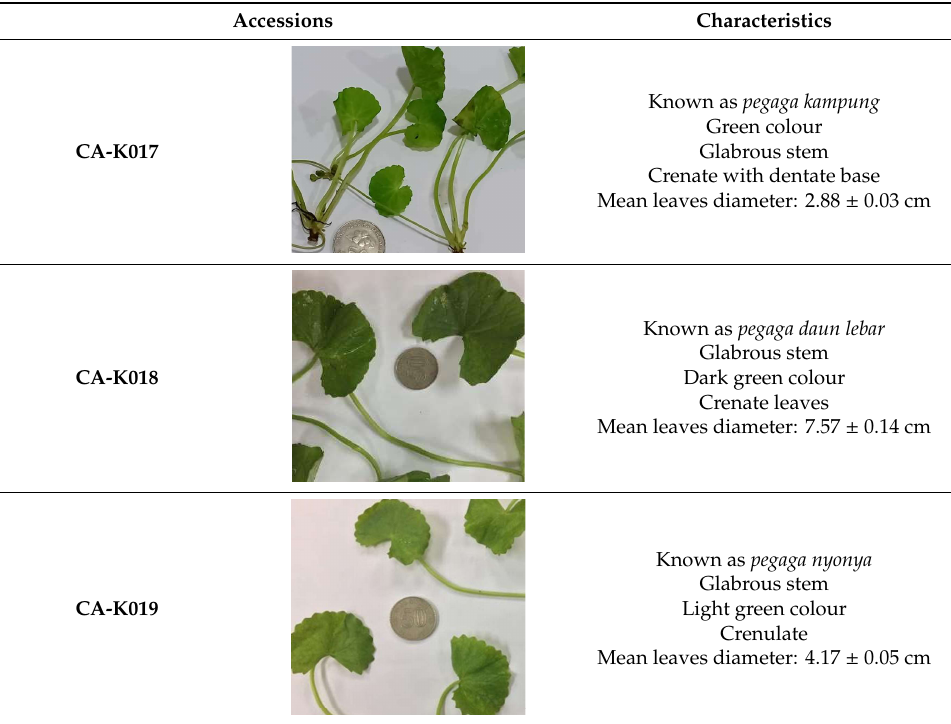
Table 1. Characterization of CA accessions.